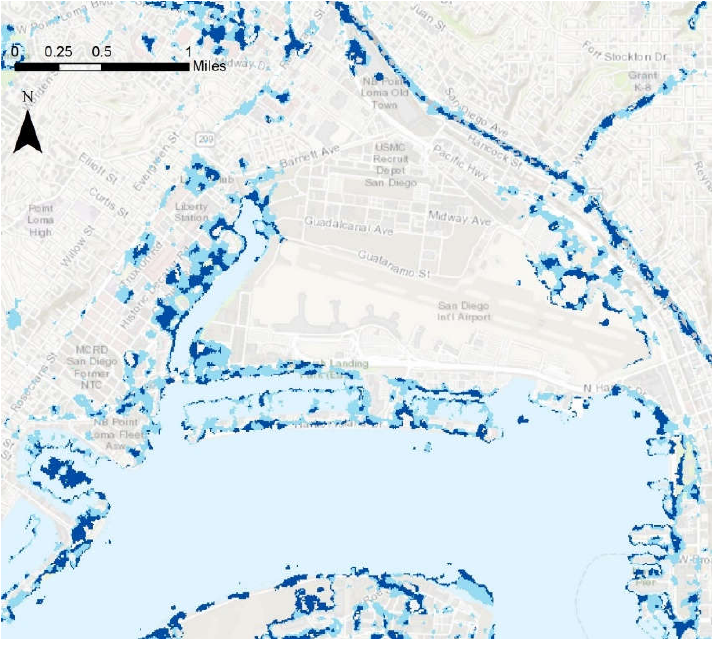
Figure 12. San Diego Airport Submap.